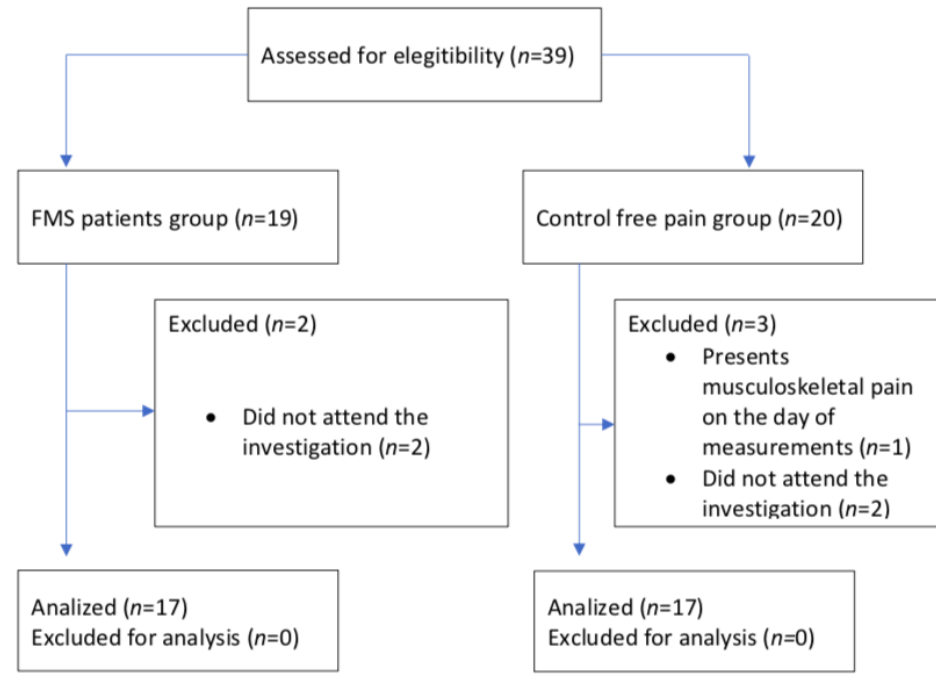
Figure 1. Study design. The following flowchart shows how the participants are distributed in the FMS study group and in the control group of healthy individuals. The discarded cases also shown, as they either did not meet the selection criteria or abandoned the investigation.